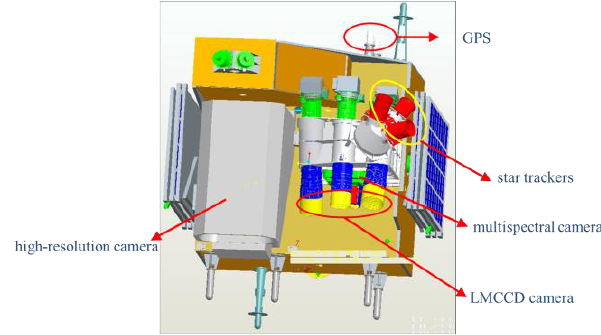
Figure 1. The main payloads of TH-1